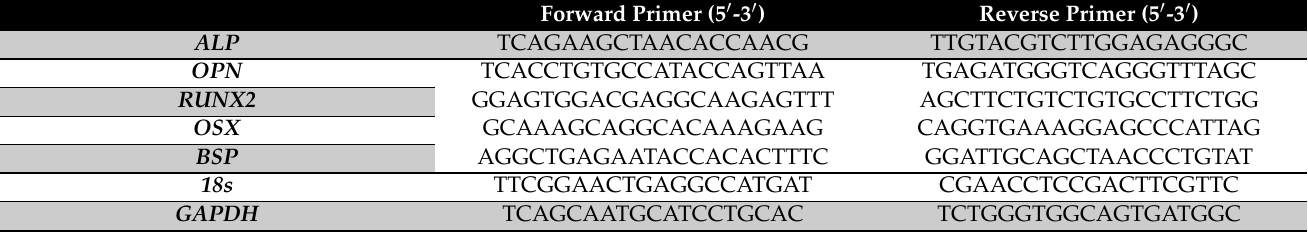
Table 1. Primers used in this